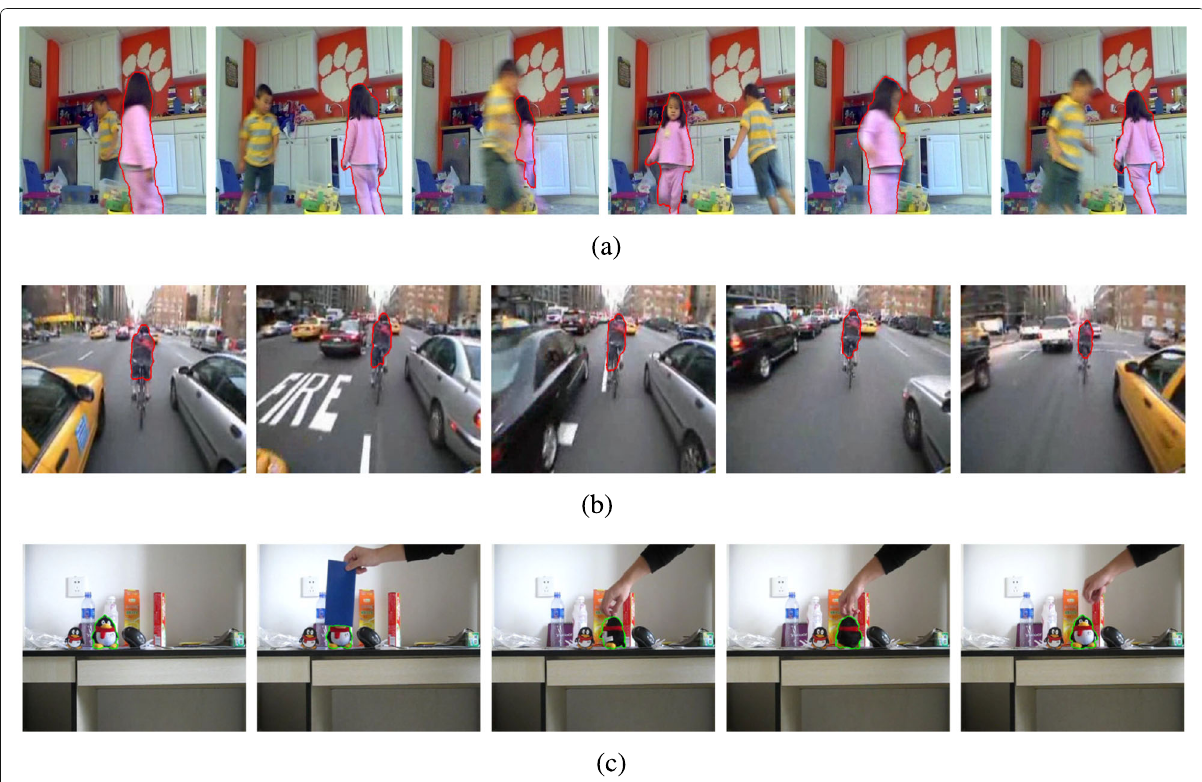
Fig. 7 Experimental results of further evaluation. a Tracking results of the proposed method on children sequence for frames of 3, 16, 28, 40, 51, and 64. b Tracking results of the proposed method on riding sequence for frames of 100, 216, 239, 268, and 367. c Tracking results of the proposed method on toy QQ sequence for frames of 0, 53, 180, 210, and